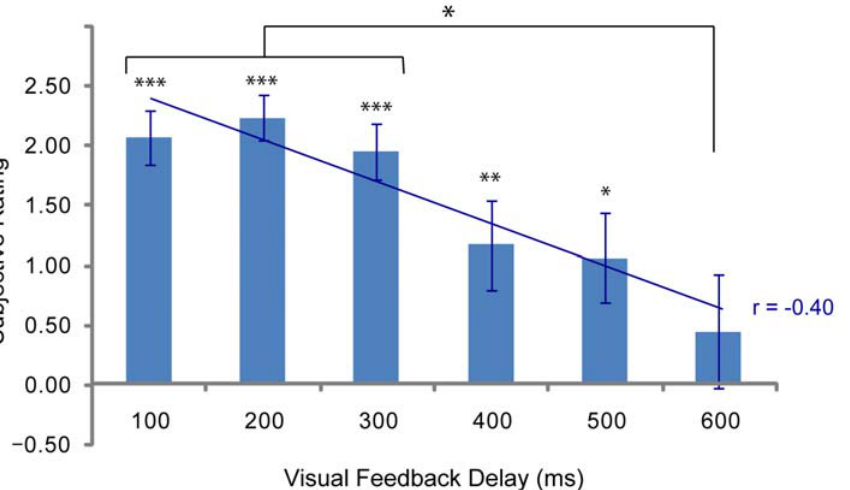
Figure 3. Subjective rating on questionnaire item 2. There were significant RHI effects in the 100 thrhough 500 ms delay conditions (***: P , 0.001, **: P , 0.01, *: P , 0.05, corrected). There were significant differences between 100–300 and 600 ms conditions (P , 0.05; Tukey HSD test).